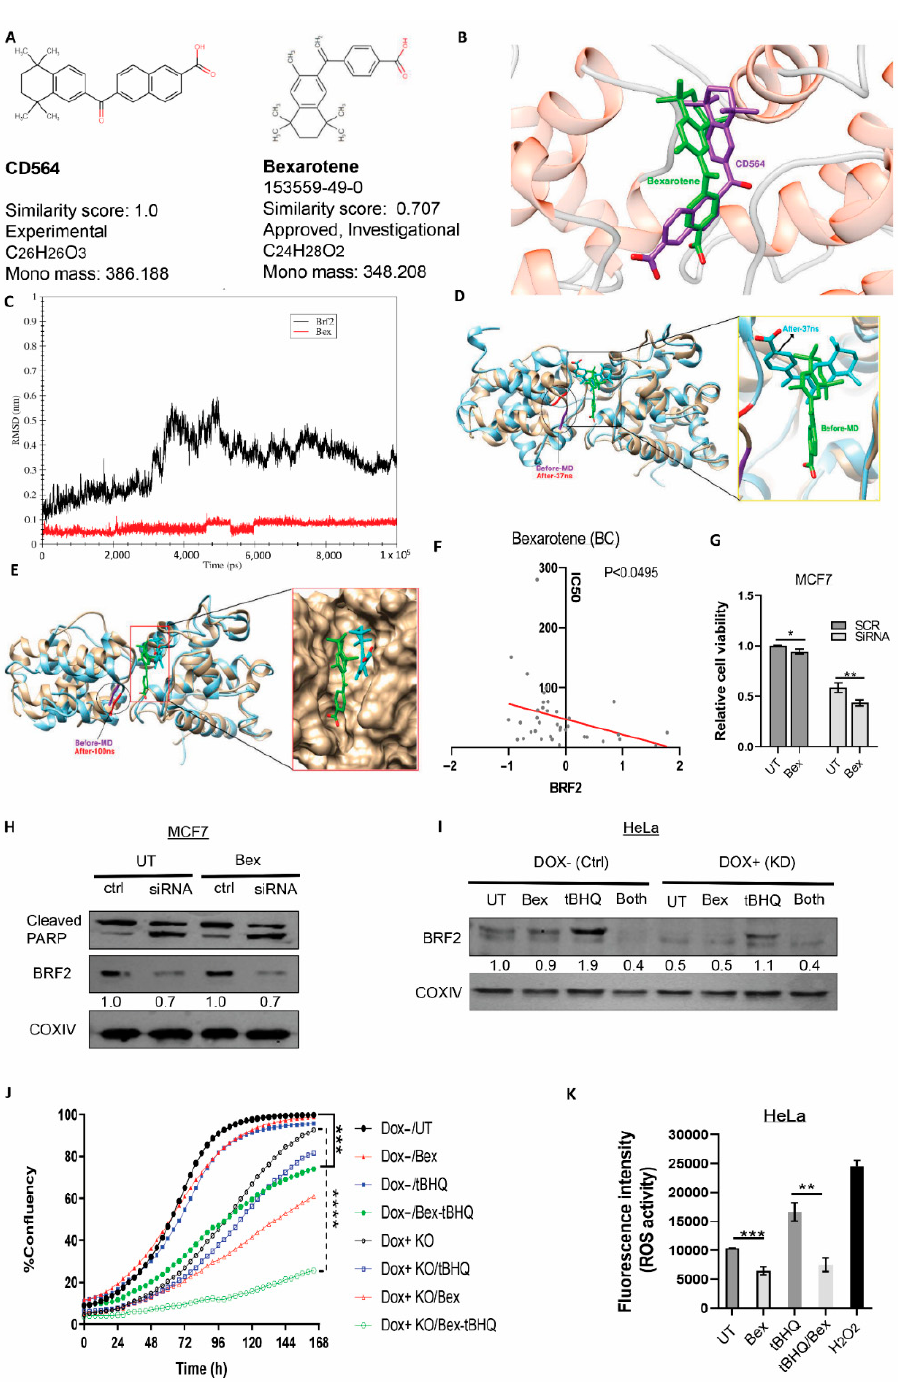
Figure 7. Effects of bexarotene (Bex) on BRF2. ( A ) Two-dimensional structure, chemical formula, and similarity score between CD564 ( left ) and Bex ( right ). ( B ) Docked BRF2-ligand complex for CD564 (purple) and Bex (green). ( C ) RMSD plot for BRF2-Bex during 100 ns of MD simulation. ( D ) Docking shows 2 conformations of the drug (before MD: green, and after 37 ns: cyan. ( E ) Docking shows 2 conformations of the drug (before MD: green, and after 100 ns: cyan. Note that the conformation of the drug has returned to its normal form. ( F ) Correlation between IC50 of Bex and BRF2 expression in breast cancer cell lines (threshold of expression is set between − 2 and 2). ( G ) Relative cell